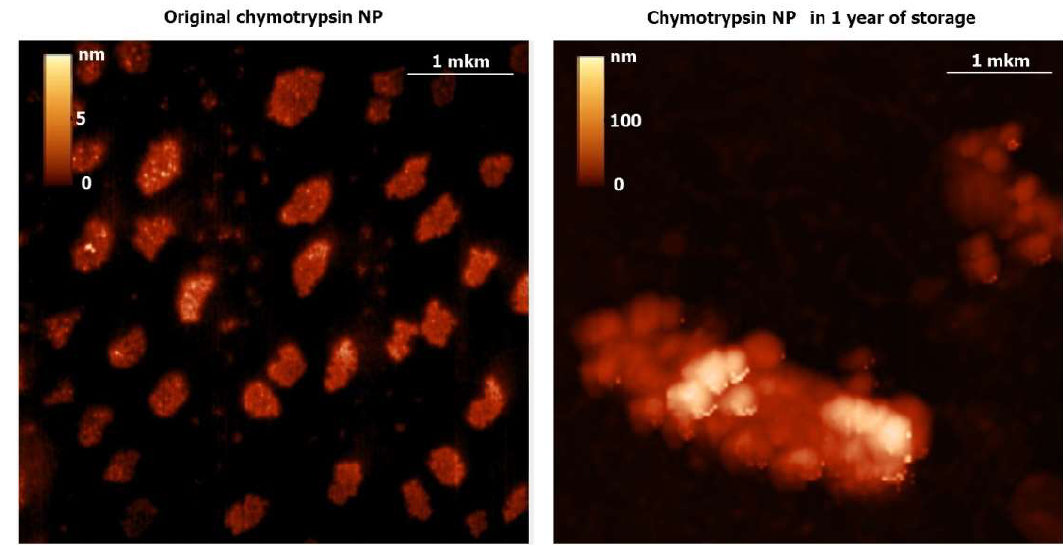
Figure 3. AFM data of the original chymotrypsin NP immediately after fabrication and in 1 year of storage at +4 °C.